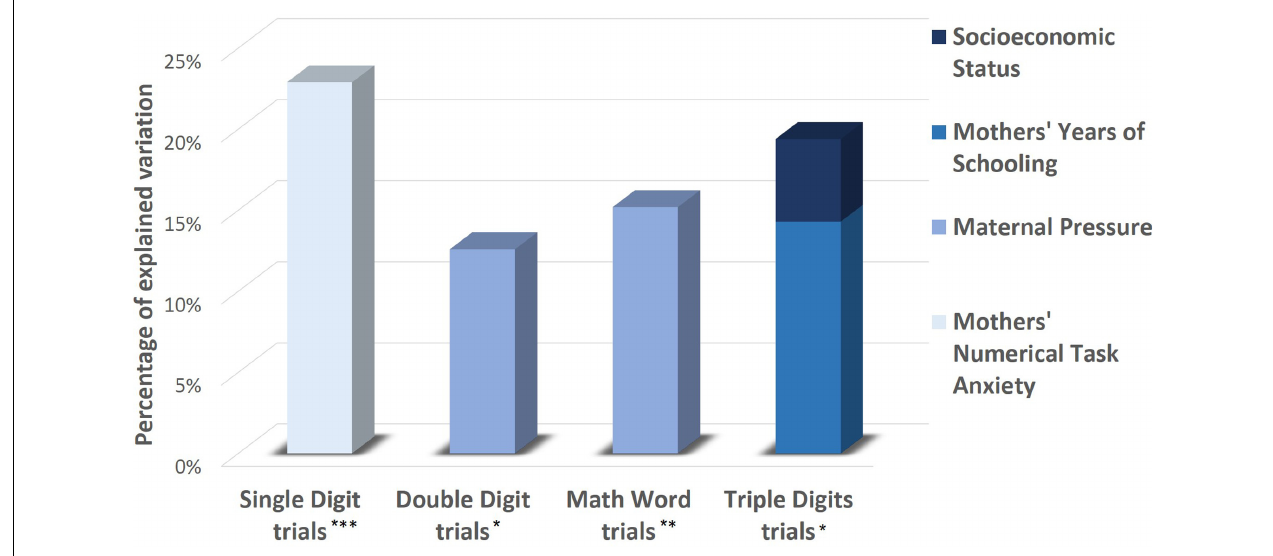
FIGURE 7 | A schematic summary of the hierarchical regression analyses to predict children’s implicitly measured math anxiety (i.e., by the numerical dot-probe task). ∗ p ≤ 0.07, ∗∗ p < 0.05, ∗∗∗ p <